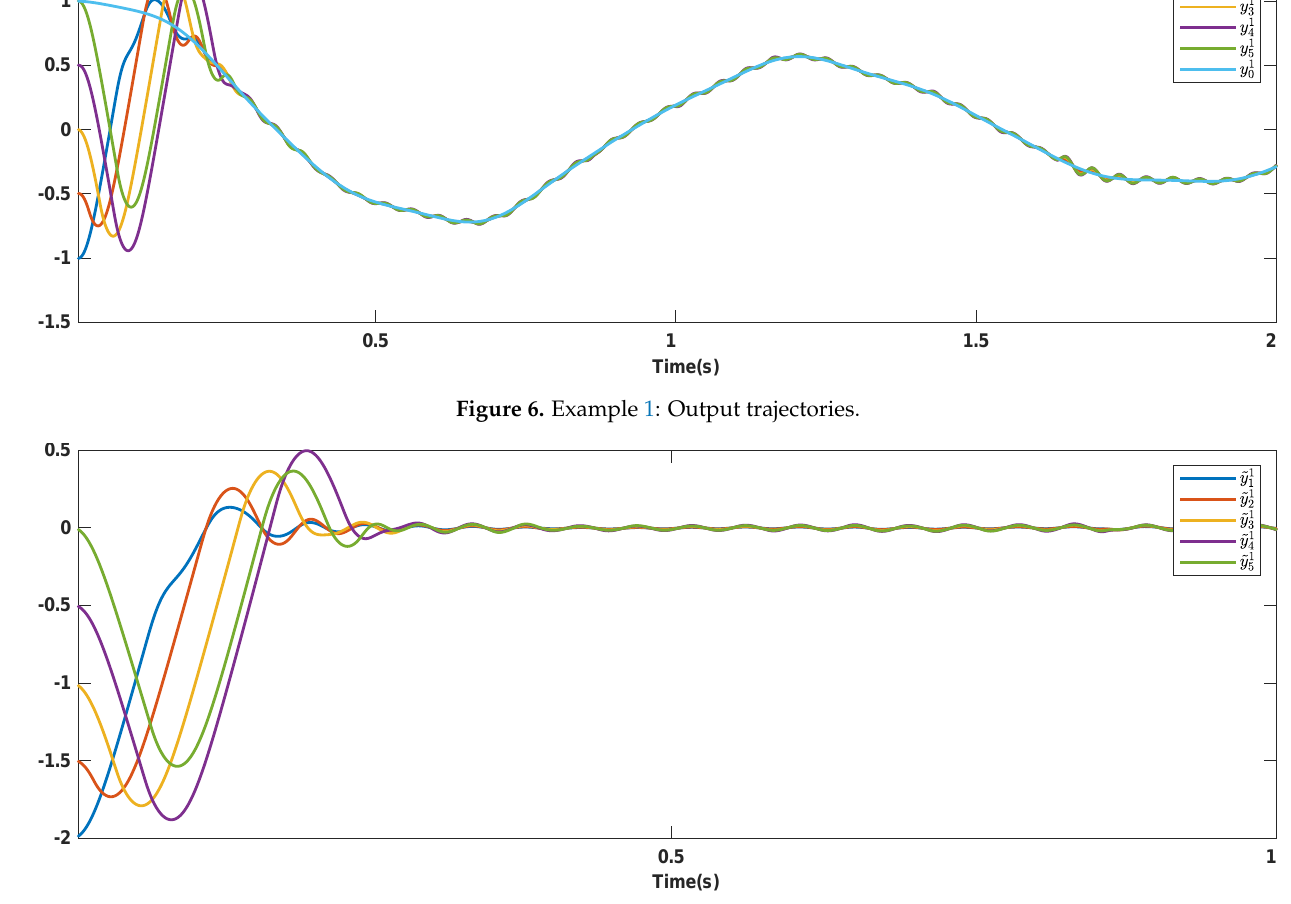
Figure 7. Example 1: Tracking error trajectories. Table 2. Example 2: Comparison